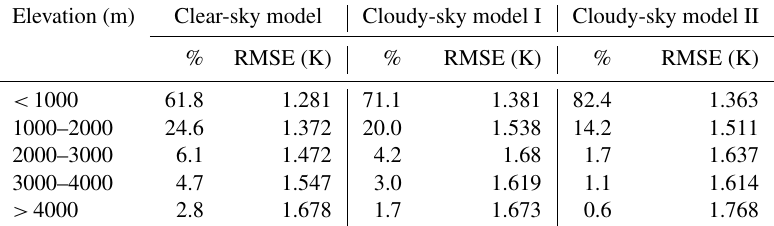
data were used as a training set for model training, and the remaining 1 group of data was used for validation. The mod- eling and validation process were repeated 14 times until the data for each year were validated. The results are shown in Fig. 8. The RMSE values of validation results for different groups of data ranged from 1.359 to 1.665 K. The minor dif- ference between the LTO CV results proved that these mod- els have good extensibility in time. For the LLO CV, we then divided seven clusters in the Chinese region using the similar separation strategy of Xiao et al. (2018). Stations used in this study were divided into different clusters according to their spatial locations, and all data pairs were divided into seven groups according to the cluster of station. In each iteration, six groups of data were used as training sets and the remaining one group of data was used for validation. The modeling and validation pro- cess were repeated seven times until the data of each group were validated. The total validation results of the models un- der the three weather conditions are shown in Fig. 9, with RMSE values ranging from 1.615 to 1.957 K. As expected, the error of the LLO CV increased relative to random sample validation. This is because the relationship between T a and other features varies with geographical location. The predic- tion error of the northwest and southwest clusters was larger than that of other clusters. The RMSE values of these two clusters exceeded 2.5 K under cloudy-sky conditions case II, whereas the RMSE values of the other clusters were about 1.5 K. This is consistent with the analysis of the spatial dis- tribution of model accuracy in Sect. 4.4 of the paper. The